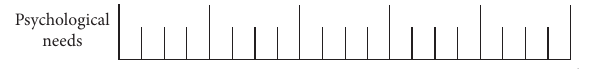
Figure 4: Schematic of the psychological demand dimension of the NASA-TLX